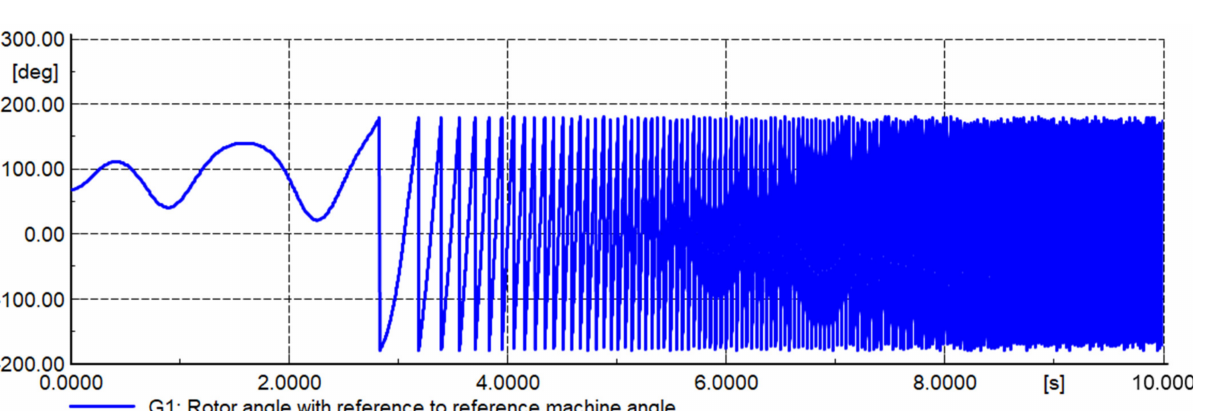
Figure 18. Test 2 : Rotor angle of G1 generator without OOS protection on CCT-1